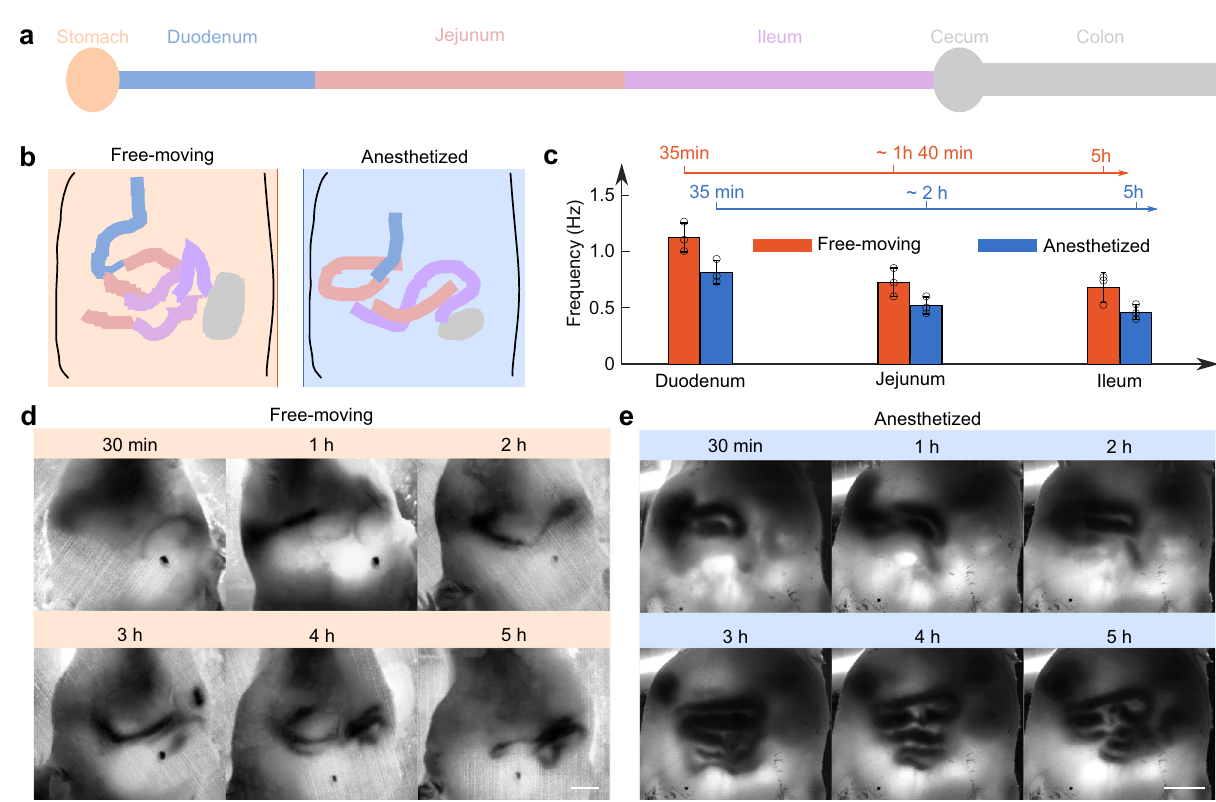
Fig. 5 Comparison of the frequency of pacemaker-driven myogenic contraction patterns in free-moving and anesthetized mice. a Schematic drawing shows the structure of intestine. b Projected intestine pro fi les of one free-moving mouse and one anesthetized mouse. c A comparison of frequency at different time points for free-moving mice and anesthetized mice. Free-moving mice showed higher motility frequency than the anesthetized mice (mean ± s.d., n = 3 mice). d The intestine of free-moving mice visualized by TIP at different time points post gavage. Scale bar: 10 mm. e The intestine of anesthetized mice visualized by TIP at different time points post gavage. Scale bar: 10